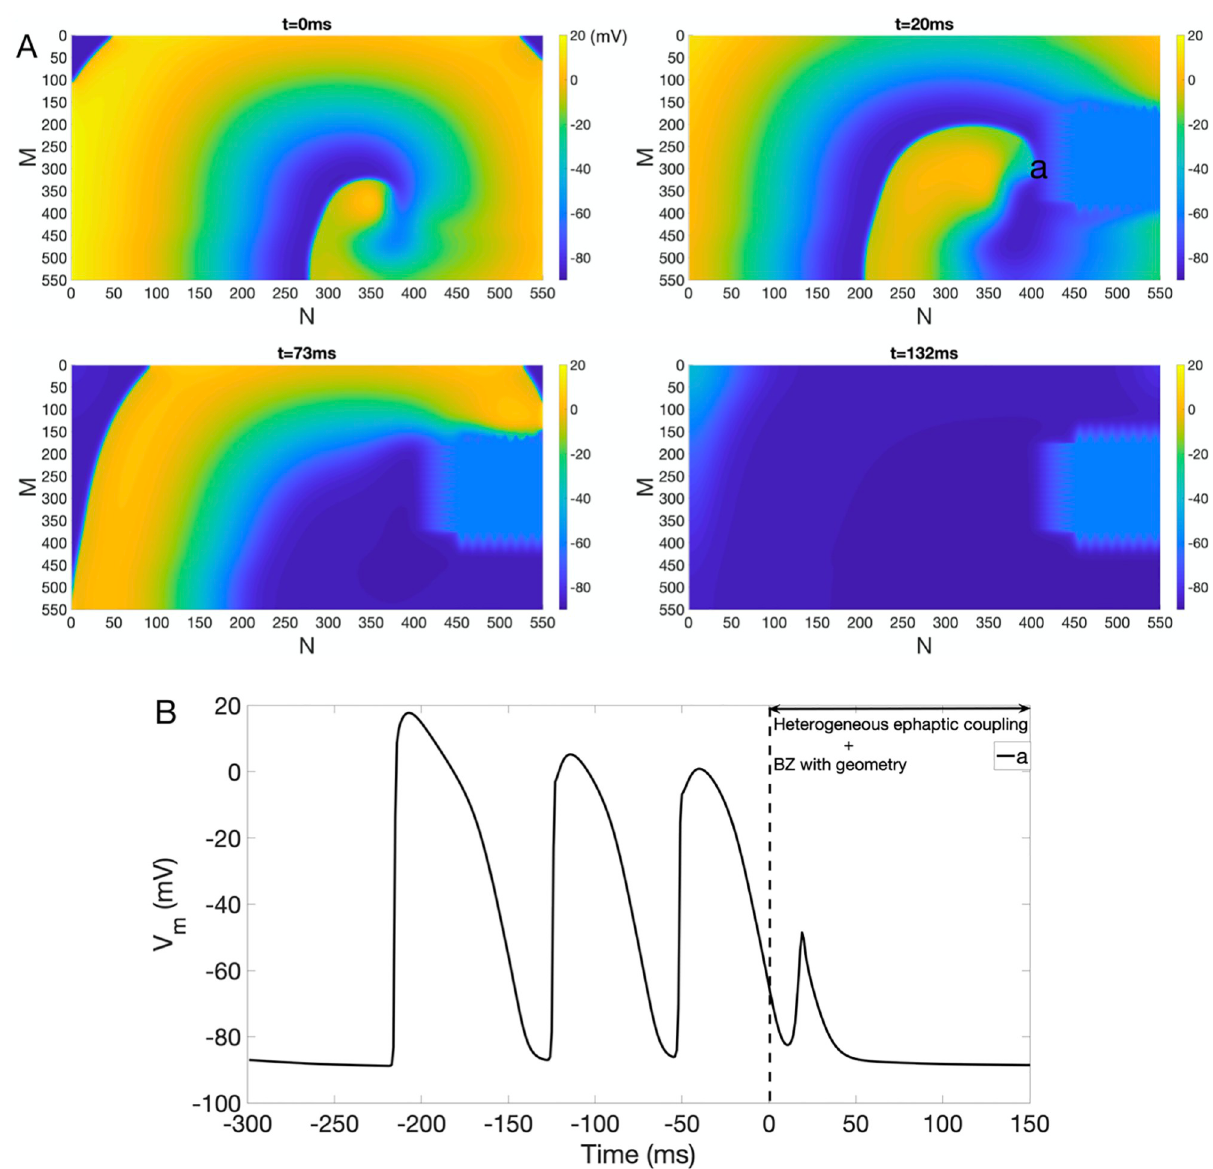
Fig 10. Inhibition of reentry under heterogeneous EpC and IC BZ with complex geometry (right). (A) Suppression of reentry in the presence of EpC present in IC BZ and part of NZ and BZ geometry on the right of the lattice. Colorbar indicates V m (in the unit of mV). Snapshots of V m at time = 0 ms, 20 ms, 73 ms and 132 ms are shown. (B) V trace of point a m